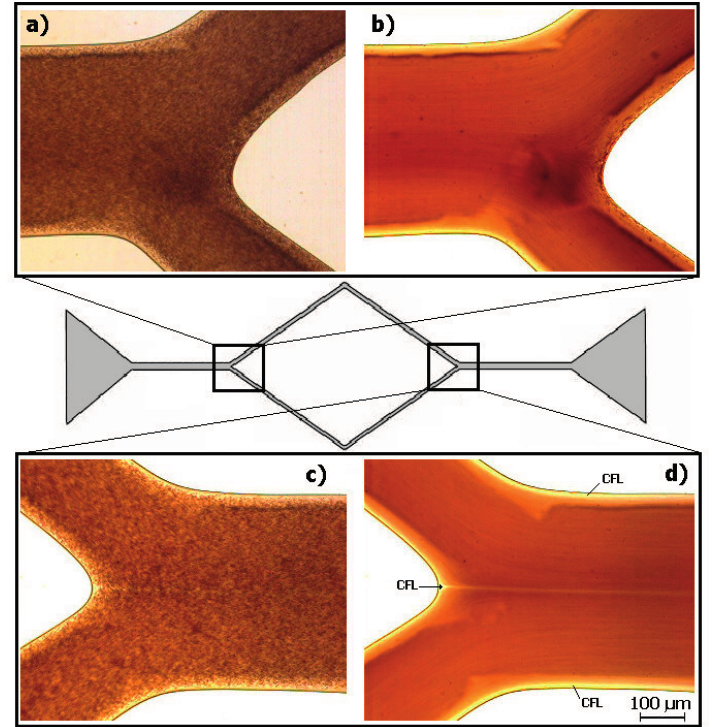
Figure 11. Visualization of in vitro blood with 15% Hct flowing in a microchannel geometry with ( a ) diverging bifurcation (original image); ( b ) diverging bifurcation (the sum of all images); ( c ) converging bifurcation or confluence (original image), and ( d ) converging bifurcation or confluence (the sum of all images). The flow rate was 10 μ